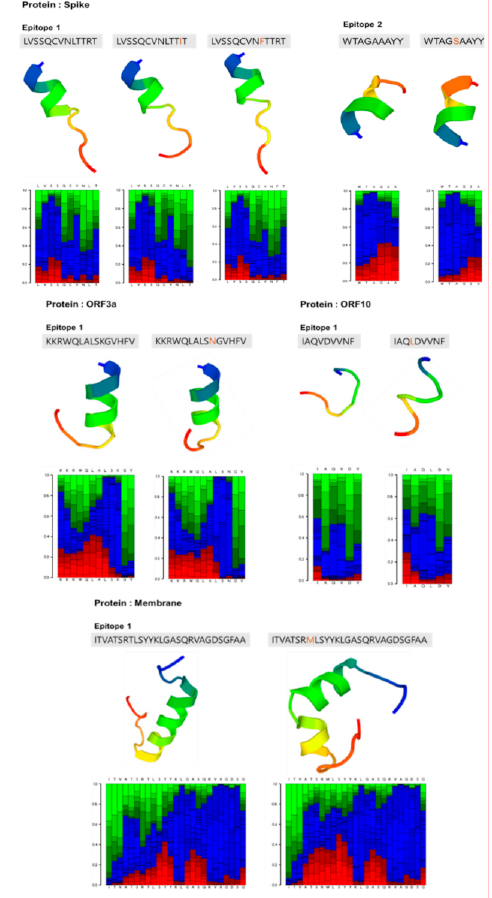
Figure 3. Structural prediction of epitopes with amino acid substitutions (Table 5) using the PEP- FOLD3 tool with their local structure prediction profile. Graphical presentation of local structure prediction profile with color codes: red, helical; green, extended; and blue,